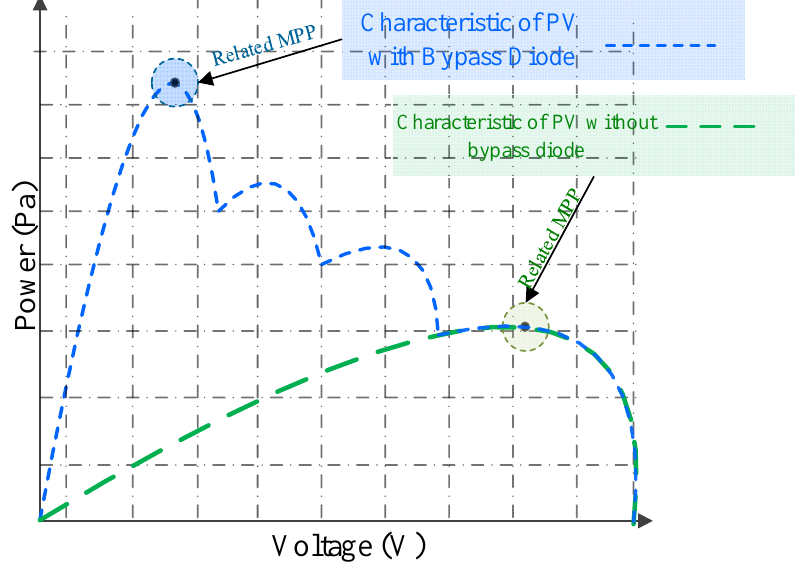
Figure 5. Power ‐ Voltage curve of a PV array subject to partial shading. Figure 5. Power-Voltage curve of a PV array subject to partial